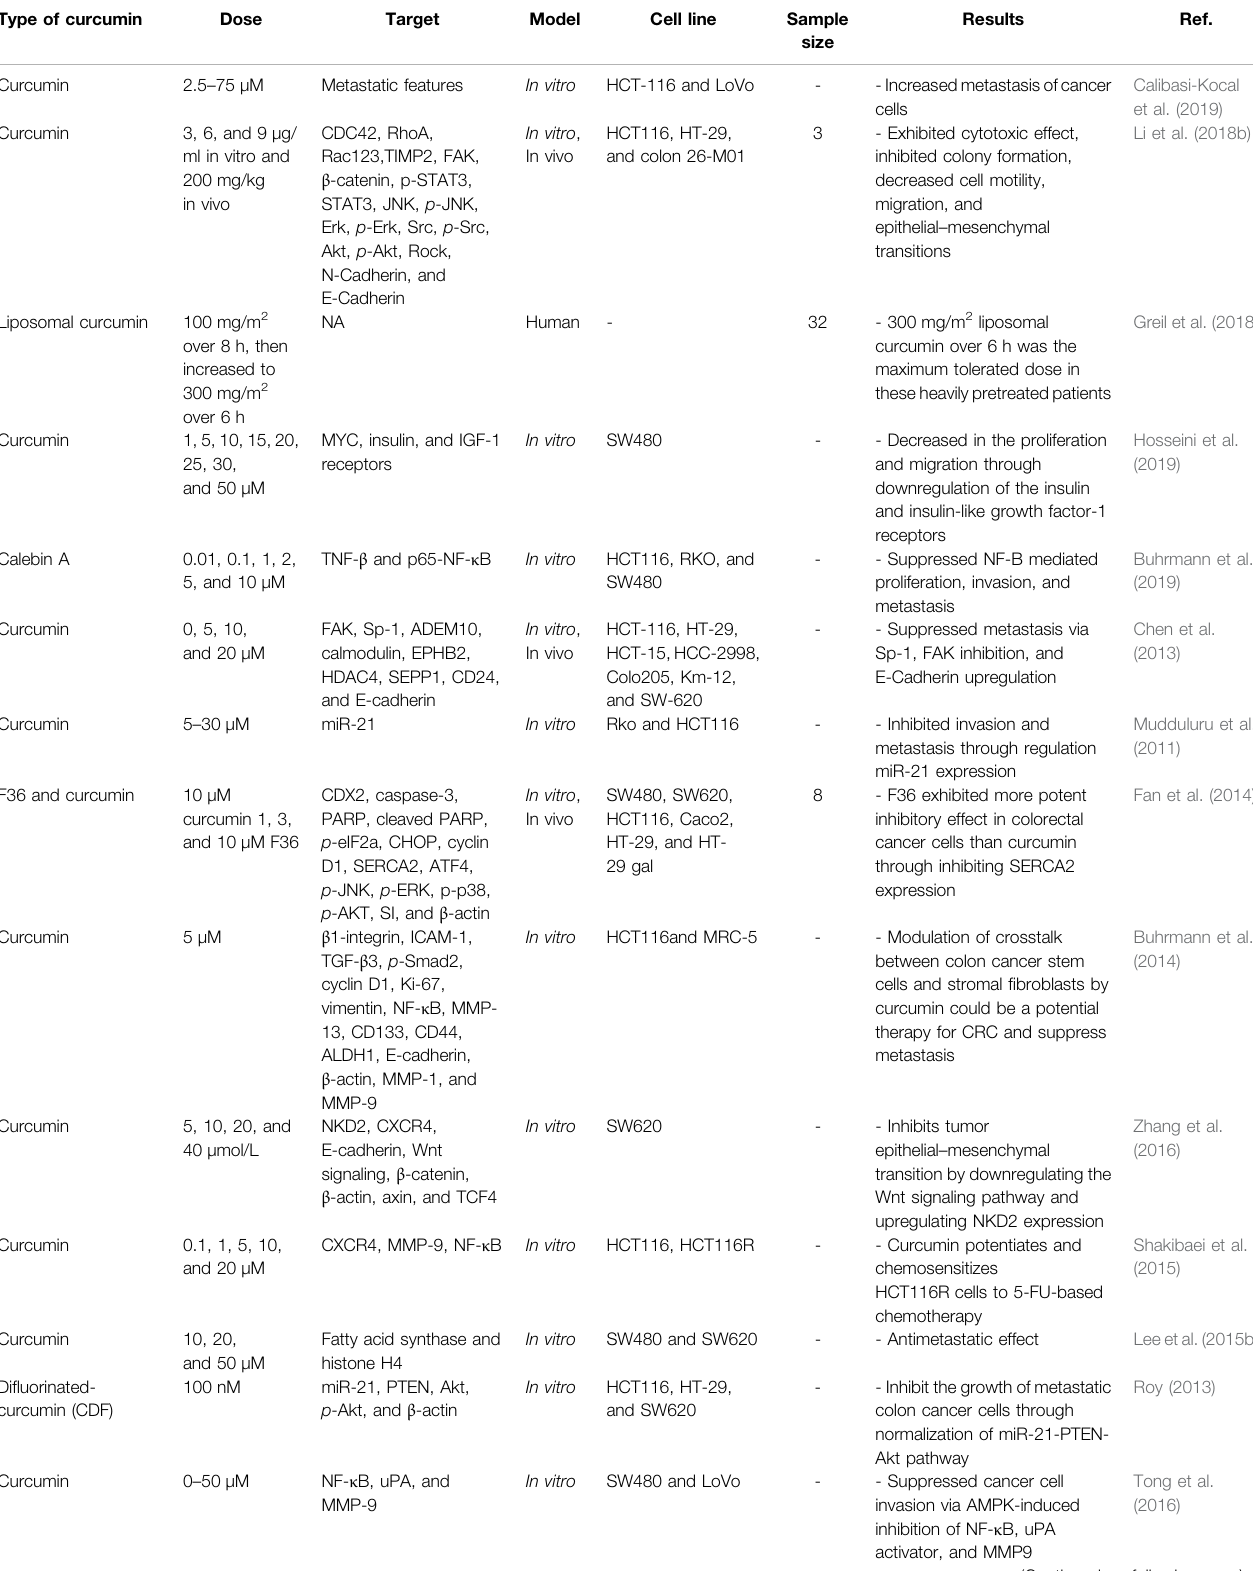
TABLE 3 | Curcumin-induced antimetastatic effects against colorectal cancer. Type of